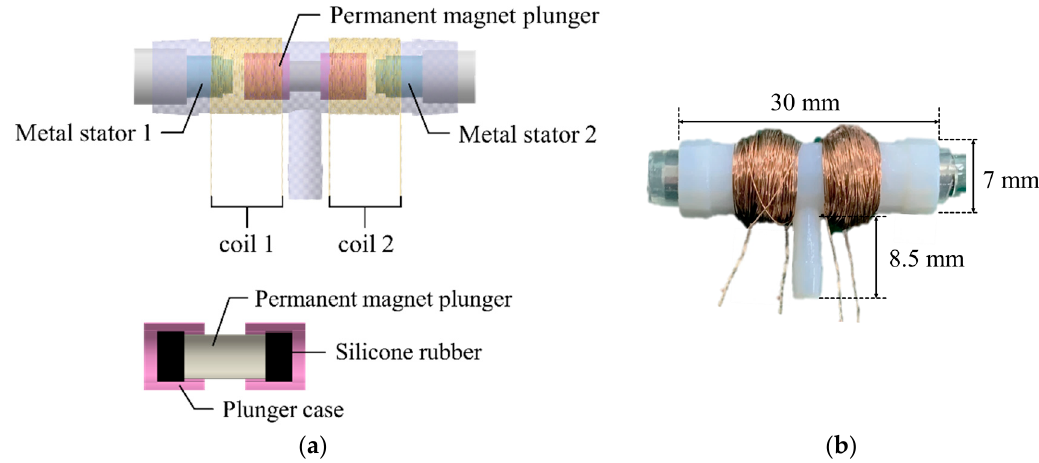
Figure 6. ( a ) The cross section of 3-way pneumatic valve; ( b ) The appearance of the pneumatic valve.